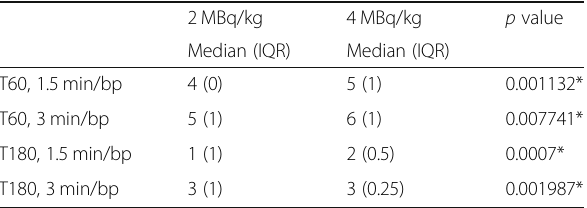
Table 3 Median, interquartile range (IQR) and p values of the image quality scores of the 2 and 4 MBq/kg groups for sets of reconstructed images (60 and 180 min p.i., 1.5 and 3 min